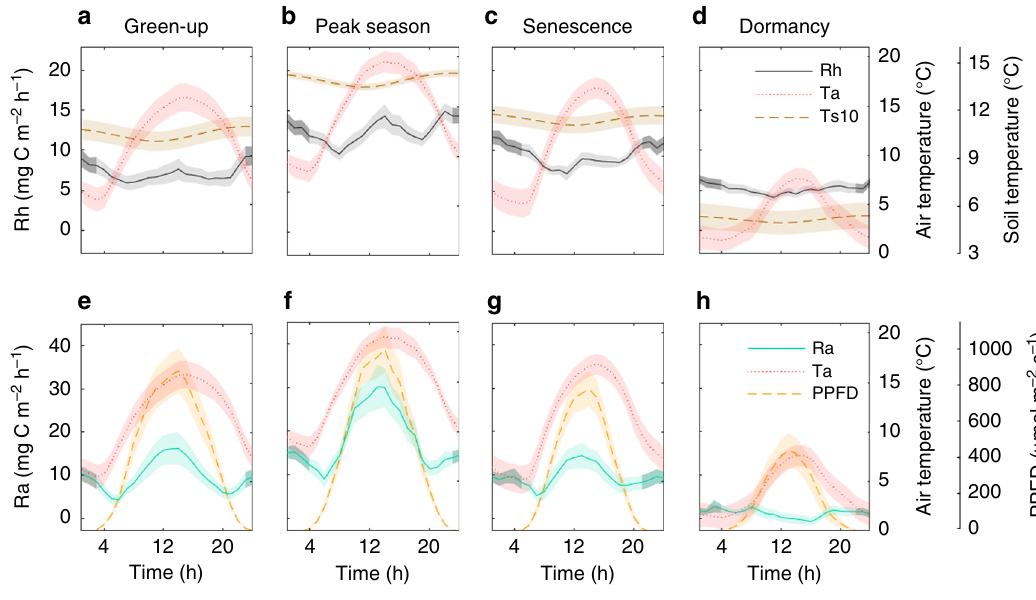
Fig. 4 Diel patterns of heterotrophic and autotrophic respiration. Diel patterns of a – d heterotrophic respiration (Rh) and e – h autotrophic respiration (Ra) and their main abiotic controls including air temperature (Ta), soil temperature at 10 cm depth (Ts10) and photosynthetic photon fl ux density (PPFD) during the phenophases of green-up, peak season, senescence, and dormancy (spring and autumn) shown as the mean over the years 2015 – 2016 (see Supplementary Fig. 6 for results from individual years; no Rh and Ra data were available in 2017). Shaded bands indicate ±1 standard error for a given hour resulting from the variation within each phenophase and across the measurement years. Darker shading in Rh and Ra shows the nighttime hours of the diel